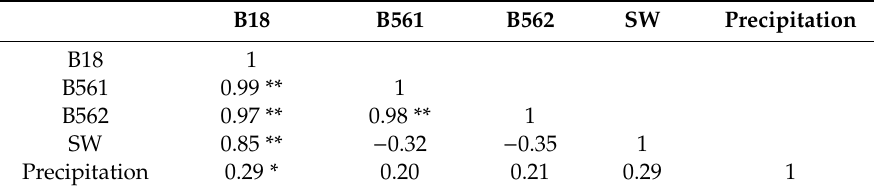
Table 1. Correlation coefficient of the SW level, GW levels, and precipitation.